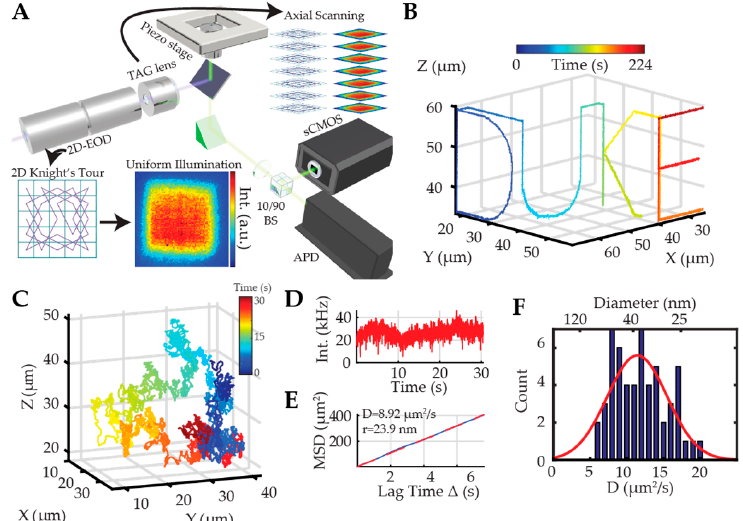
Figure 10. (a) Schematic of 3D-DyPLoT. A 2D-EOD is used to deflect the laser in X and Y in a